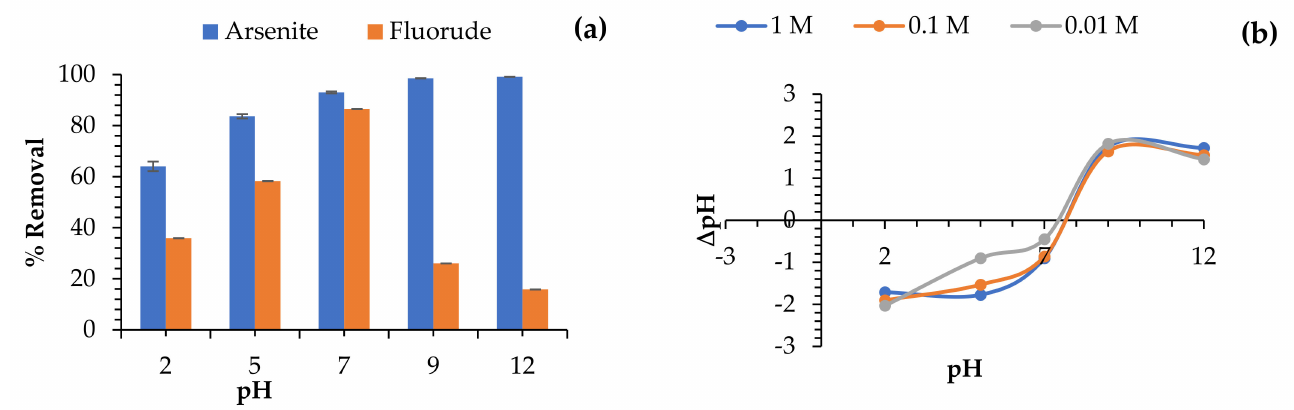
Figure 11. Effect of pH ( a ) and pH pzc ( b ). Initial As 3+ and F − concentration: 5 and 10 mg/L; adsorbent dose: 0.25 and 0.2 g; solution volume: 50 mL; contact time: 40 min; shaking speed: 250 rpm; and temperature: 297